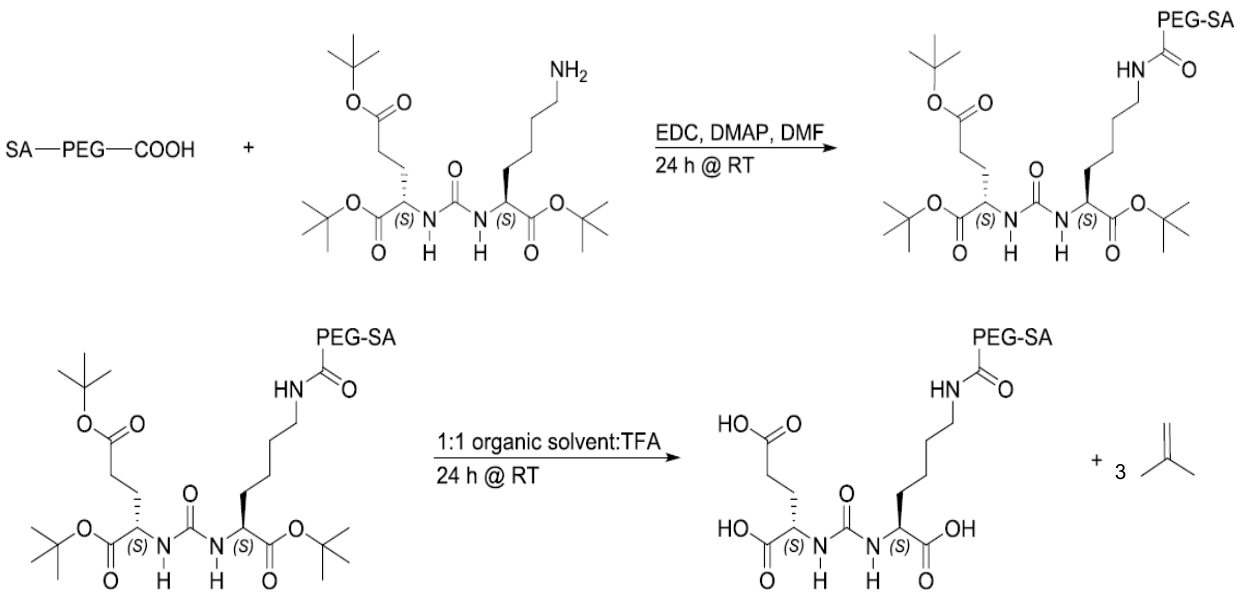
Figure 1. Synthesis of SA-PEG with PSMA TL Glu-Urea-Lys. SA-PEG-COOH was conjugated to Glu-Urea-Lys with protecting groups of tert-Butyl esters. The SA-PEG-TL was subjected to acidic conditions for the removal of the protecting groups, hence regaining the carboxylic groups of the PSMA TL.